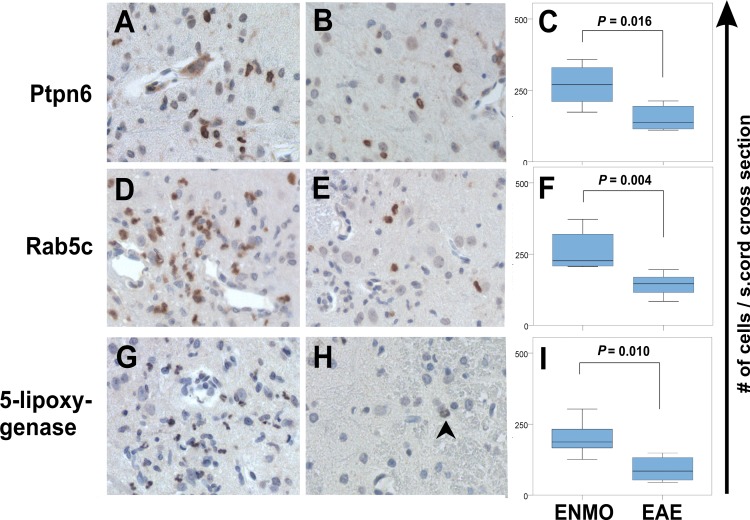
Confirmation by immunohistochemistry of differential expression of Ptpn6, Rab5c and 5-lipoxygenase in ENMO and EAE.Shown here are cross sections of spinal cords from animals with ENMO (A, D, G) and EAEcoI, (B, E, H) reacted with antibodies against Ptpn6 (A, B), Rab5c (D,E) and 5-lipoxygenase (G,H). Reaction products are brown. Counterstaining was done with hematoxylin to reveal nuclei (blue). Statistically significant differences in the number of Ptpn6- (C), Rab5c- (F), and 5-lipoxygenase- (I) positive cells / spinal cord sections between ENMO and EAEcoI are seen (Mann-Whitney U-test). Shown here are medians (range). The arrow in (H) points to a weakly stained nucleus of a neutrophil.